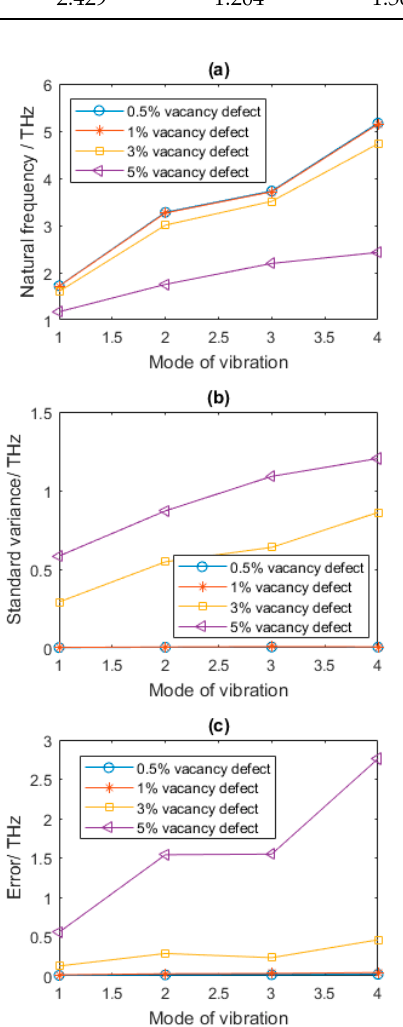
Figure 5. Results of defected graphene sheets with different amount of vacancy defects ( a – c for mean, standard variance and Error of natural frequency, respectively).